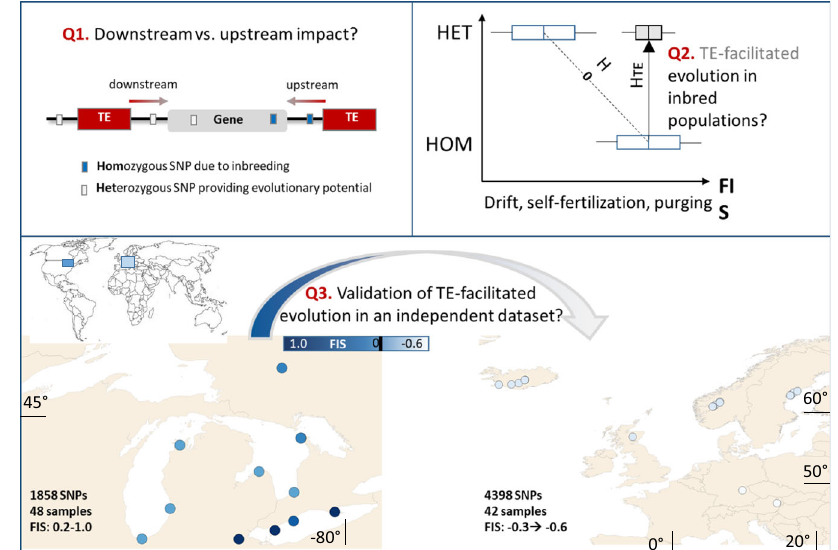
Fig.1|Overviewofresearchquestions. Researchquestions(Q1-Q3)ontheroleof TE-facilitated evolution under inbreeding, with F IS representing the genome-wide inbreedingcoef fi cient.InQ2,thegrayboxplotrepresentsaTE-mediatedshiftinthe expected negative relationship betweeninbreedingand heterozygosityfrom H 0 to H TE .ForQ3,theleftpanelshowstheNorthAmericanGreatLakesregion(left)where